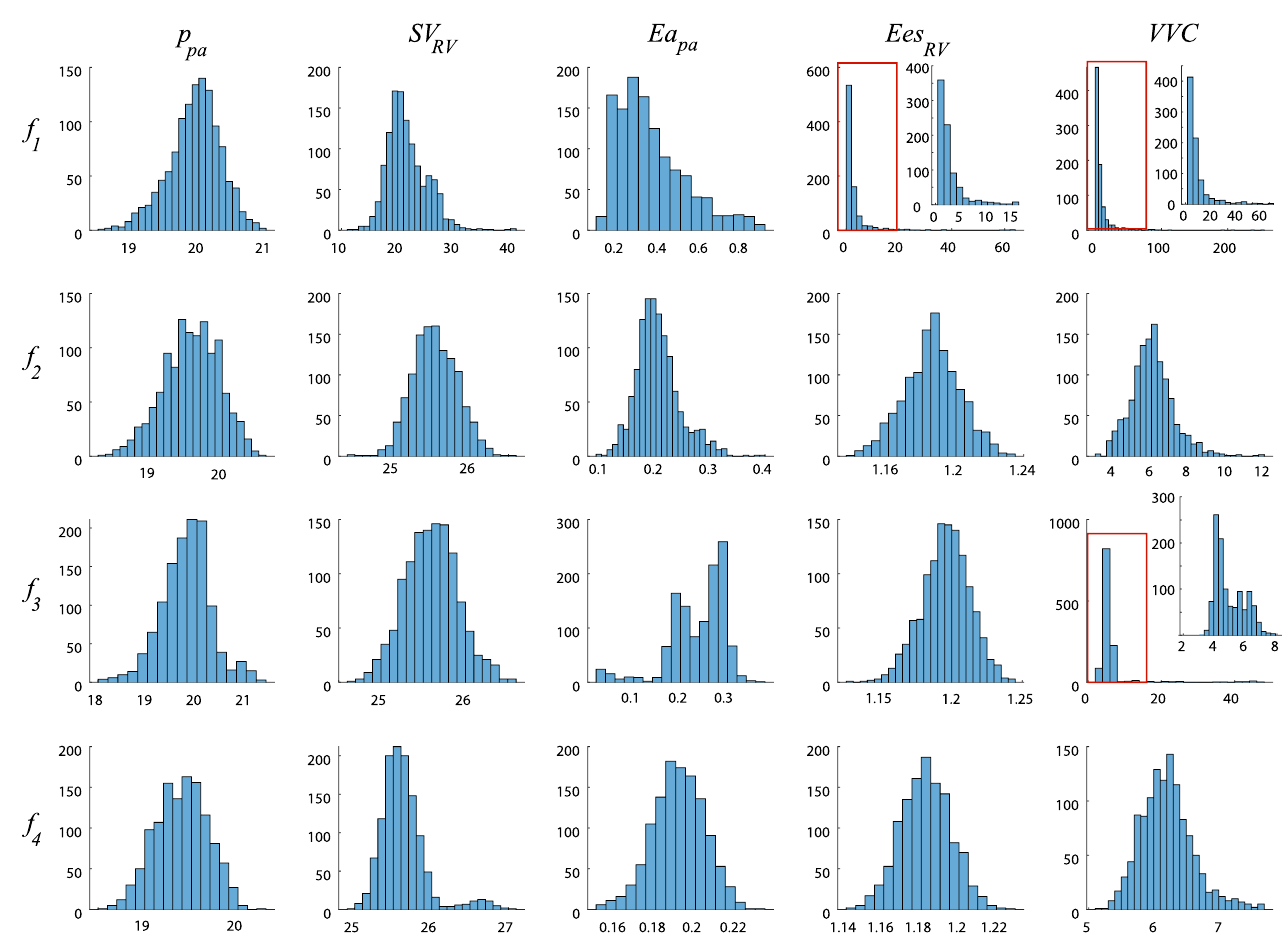
Fig 12. Simulated output quantities that are typically recorded when studying PH. Histogram plots of outputs typically recorded during in-vivo studies of PH progression are generated using the same 600 samples from the posterior that were used in Figs 9, 10 and 11. These include mean pulmonary artery pressure ( � p ), RV stroke volume ( SV , defined as difference between maximum and minimum RV volumes), pulmonary arterial elastance ( Ea RV sa difference between � p and mean LA pressure divided by SV RV ), RV end systolic elastance ( Ees RV , defined as the end systolic ratio of RV pressure and RV sa volume), and ventricular-vascular coupling ( VVC , defined as the ratio Ees / Ea ). Differences in the experimental design had little effect on � p RV pa SV RV was more accurately captured with additional RV volume data. The wide variability in values of Ea pa , Ees RV , and VVC using the design f 1 is remedied once additional volume data is included in the design. Note that output values of VVC are made substantially more precise with additional LV data in f 3 and f 4 .